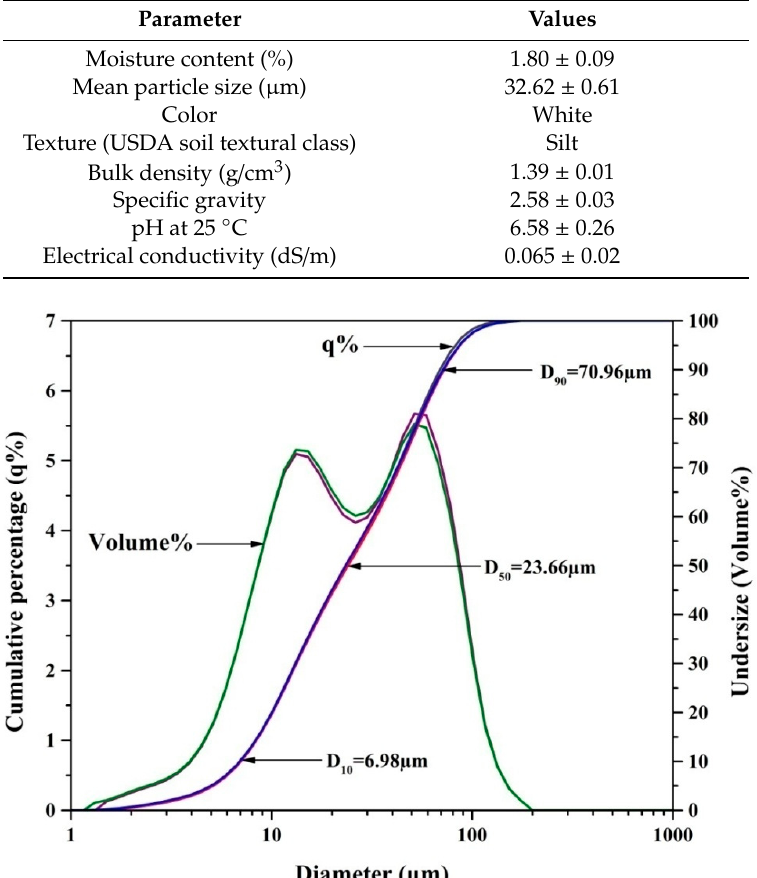
Table 1. Physicochemical properties of marble waste particulates.